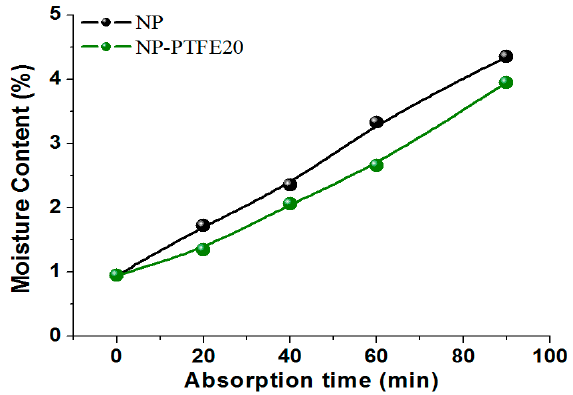
Figure 13. Moisture content of the NP and NP-PTFE20 samples under the absorption moisture condition.